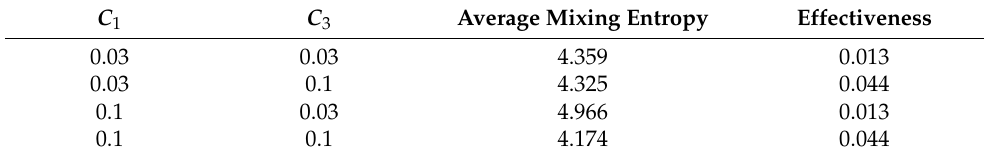
Table 1. Mixing entropy and effectiveness for different ( C 1 , C 3 ) value